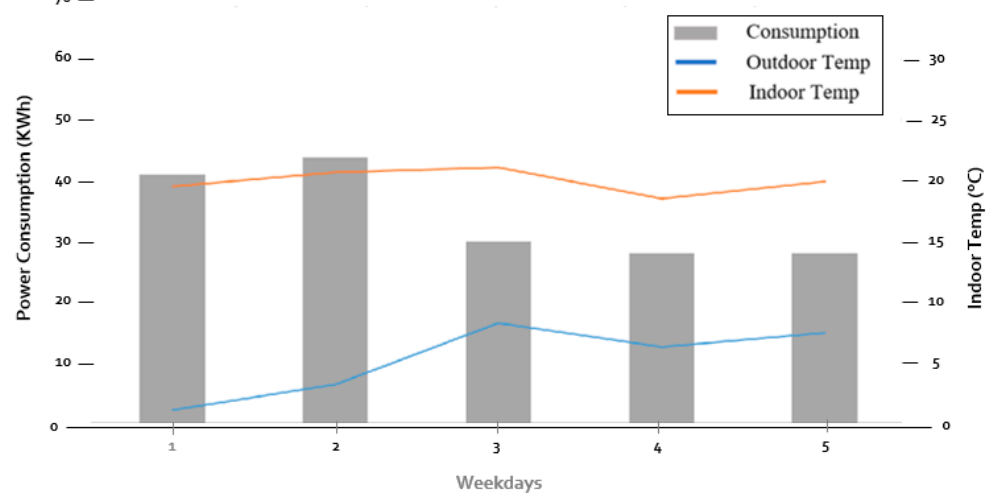
Figure 8. Lighting consumption profile with dimming (10-min level granularity).